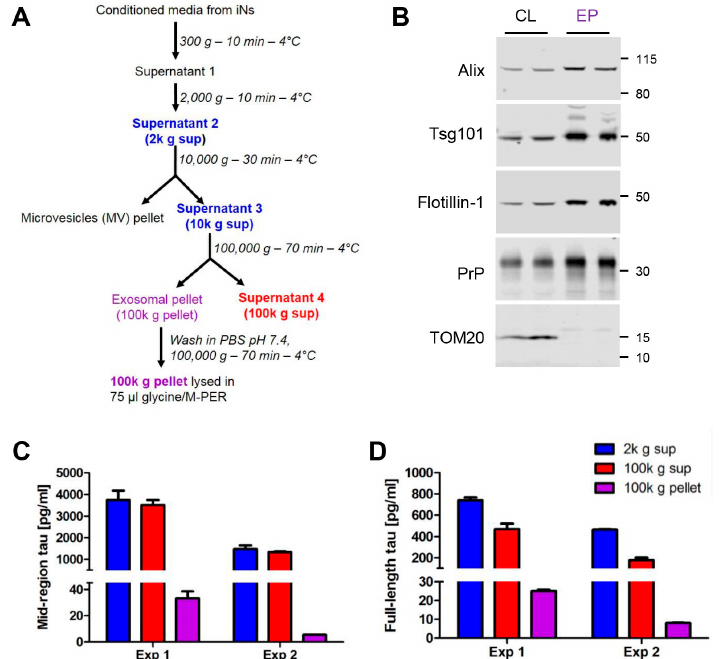
Figure 3. Exosomes from human iPSC-derived neurons contain detectable levels of full-length, aggregation-competent tau. ( A ) Flow chart describing the centrifugation procedure used to isolate exosomes from conditioned medium (CM). The speed, duration and temperature of each centrifugation step are indicated to the right of the arrows. Immediately after collection, CM was centrifuged at 300× g to remove dead cells and then 2000 g to remove cellular debris. The clarified CM was then centrifuged at 10,000× g to pellet microvesicles. The resulting supernatant (S3) was centrifuged at 100,000× g for 70 min to pellet exosomes, and these were washed once in PBS. The wash supernatant was discarded and the final exosomal pellet was lysed in glycine/MPER buffer. CM from two separate iN cultures, designated Experiment (Exp) 1 and Exp 2, was collected and processed as described. A portion of exosomal pellet (EP) lysate was analyzed by Western blotting alongside thecell lysates (CL) of iNs from which the exosomes were derived ( B ). Antibodies used are indicated on the left and the migration of molecular weight standards (in kDa) is on the right. Tau was measured in CM (2000 g (blue) and 100,000 g (red) supernatants and the lysed 100,000 g exosome pellet (purple) using our mid-region ( C ) and full-length (FL) ( D ) ELISAs. Concentrations represent the amount of analyte present in 1 mL of starting iN CM and account for dilution and concentration steps. Results for each culture (Exp 1 and 2) represent mean ± SD of technical